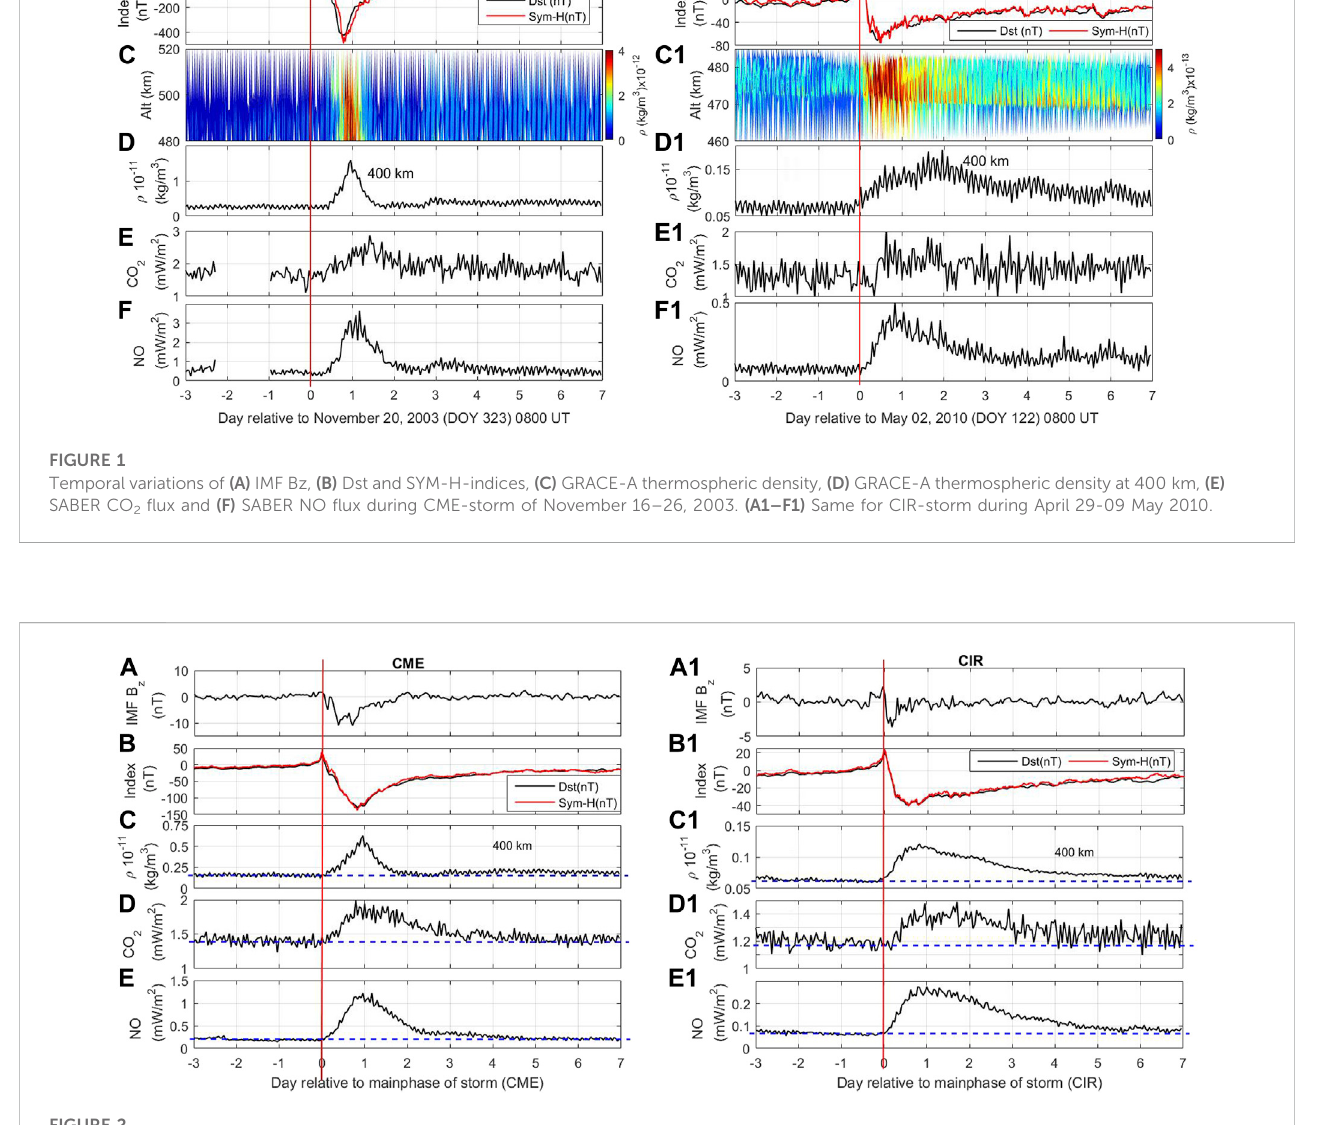
FIGURE 2 SuperposedEpochAnalysisfor(left)CMEand(Right)CIRstorms. (A) IMFBz, (B) Dst-andSYM-Hindices, (C) GRACEthermosphericdensityat400 km, (D) SABER CO 2 fl ux and (E) SABER NO cooling fl ux during CME storm. (A1 – E1) Same for CIR-storms. All data are binned into 1 h average. Vertical red lines mark the time of main phase. The horizontal dotted lines represent the pre-event